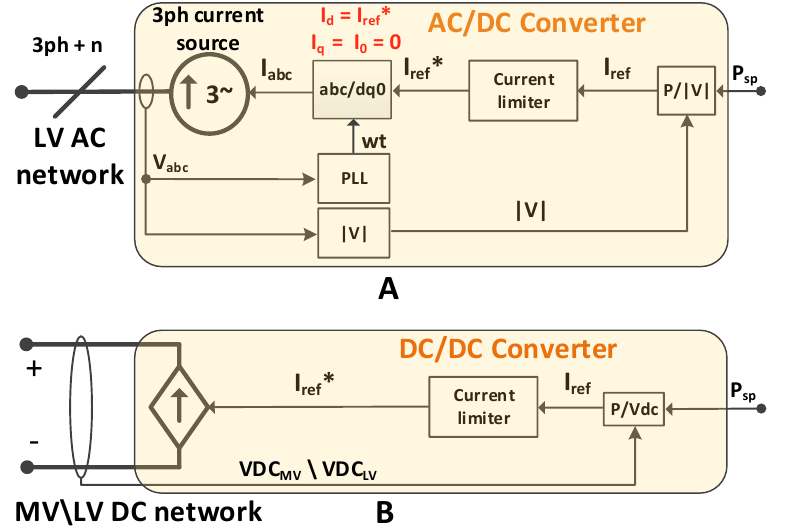
Figure 9. Block diagram of the developed computational model for the controllable AC ( A ) and DC ( B ) Distributed Energy Resources (DER)